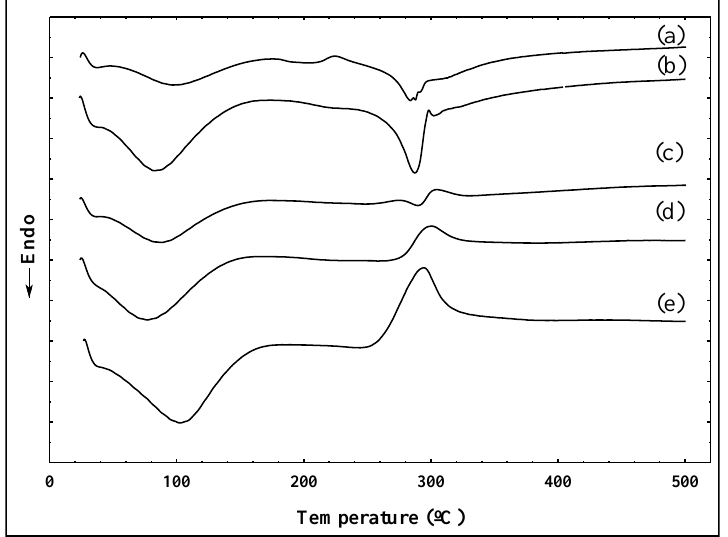
Figure 3. DSC thermograms of SF/CHI blended films with the ratio SF:CHI of (a) 100:0,